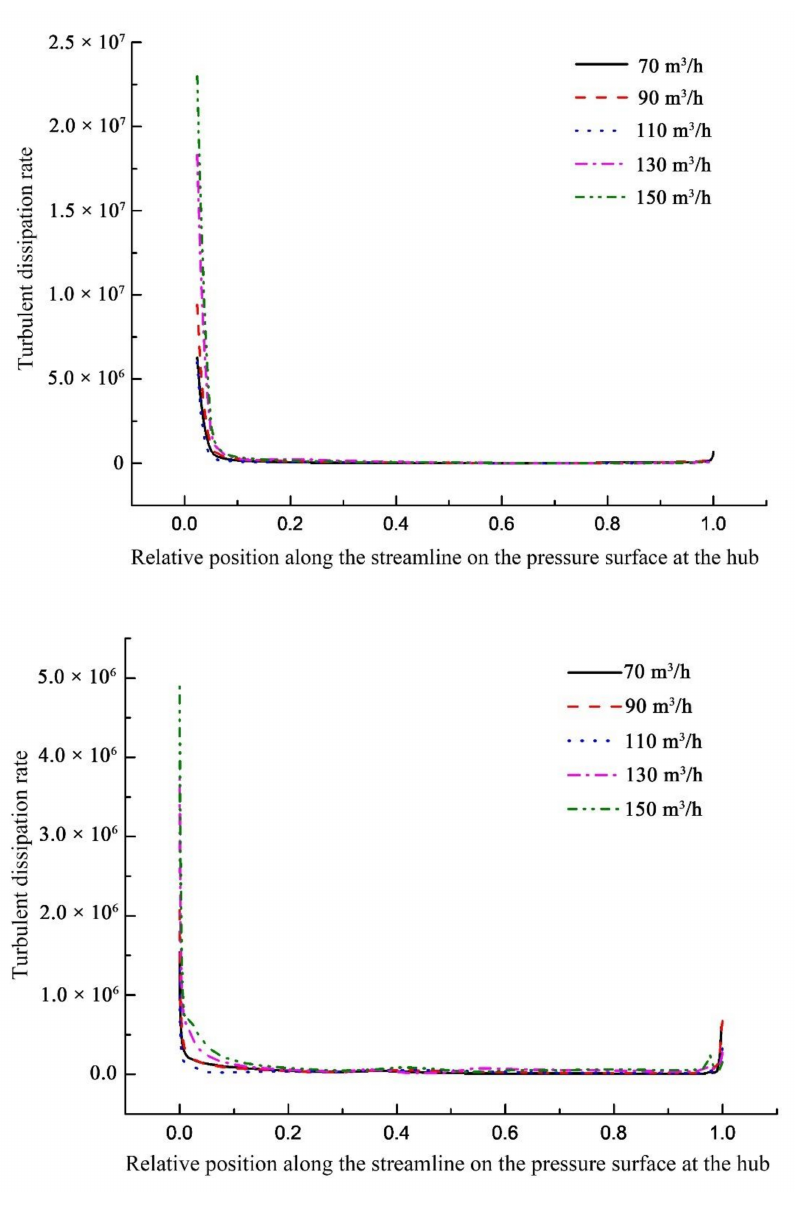
Figure 10. The turbulence dissipation rate distribution pattern of the pressure surface and the suction surface of the first-stage impeller blade at the hub with different flow